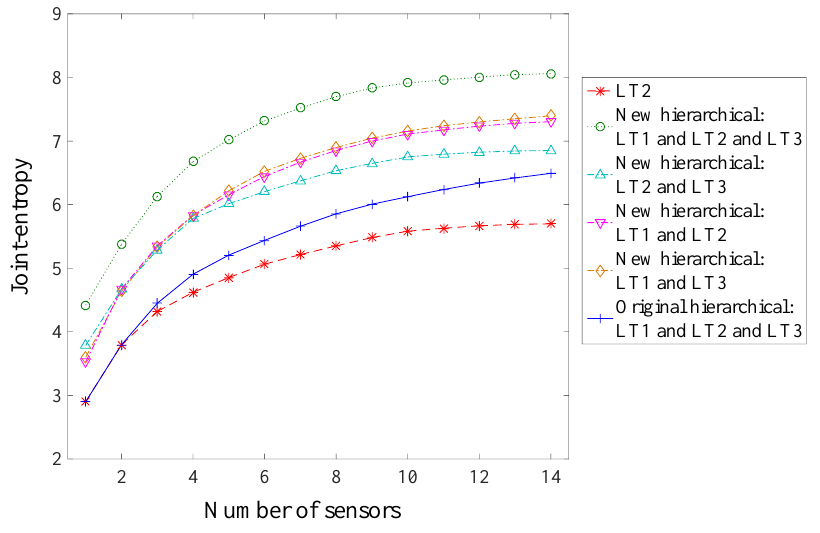
Figure 14. Joint entropy as a function of the number of sensors for various configurations of load tests.